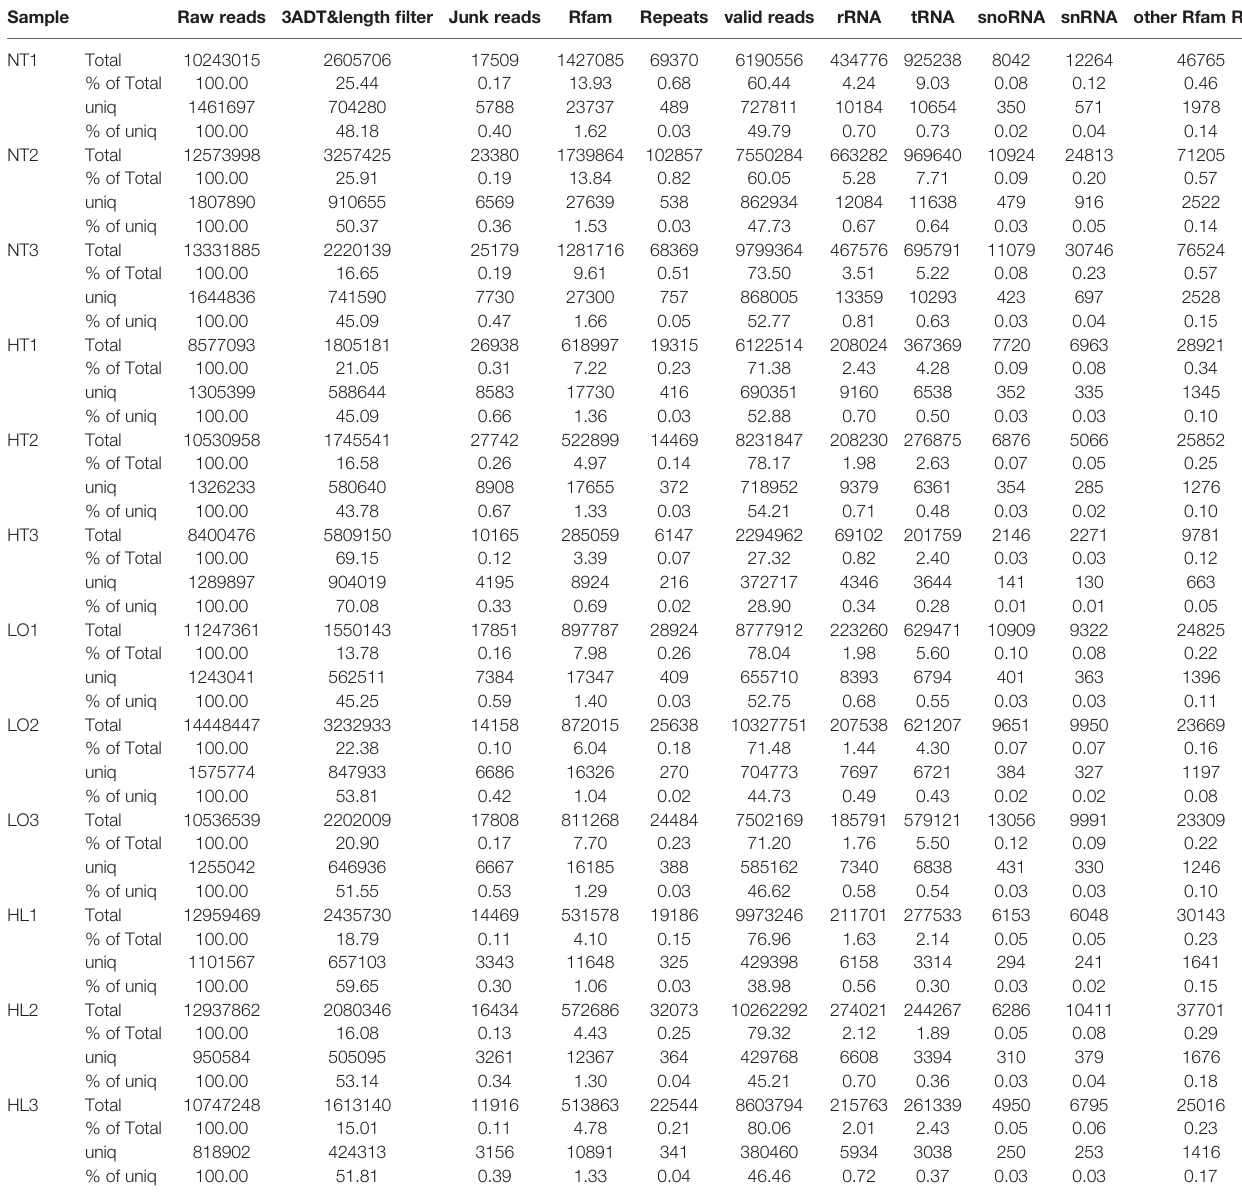
TABLE 2 | Overview of reads from raw data to cleaned sequences.